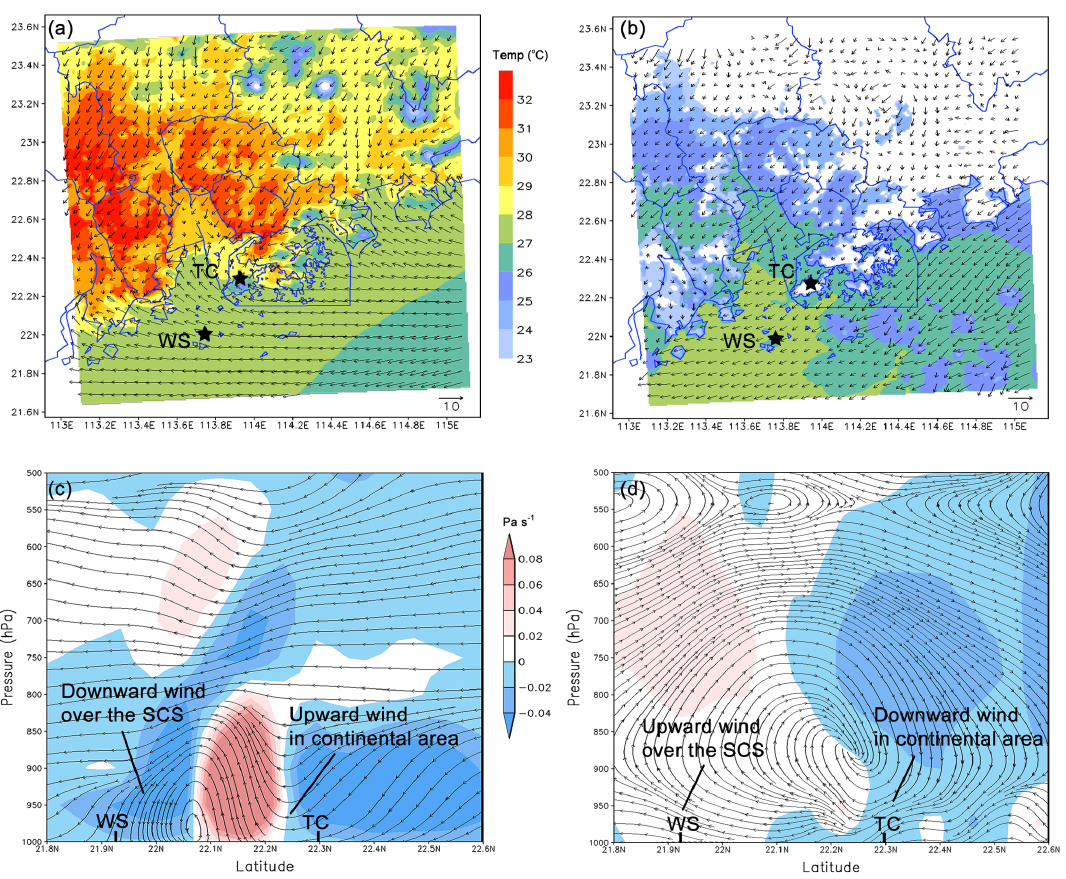
Figure 4. SLB circulation on 3–4 October 2013, showing surface wind pattern (arrows) and temperature (color) at 17:00 on 3 October (a) and at 04:00 on 4 October (b) . Vertical cross section (taken over a longitude of 113.85 ◦ E, mean of the longitudes of TC and WS) depicting the v – w wind stream (arrow) and the index of ω · 100 (color) at 17:00 on 3 October (c) and at 04:00 on 4 October (d) . For panels (c) and (d) , the blue color (negative) and light red color (positive) present downward and upward winds, respectively. Panels (a) and (c) represent a sea breeze, and panels (b) and (d) show a land breeze. Note that ω is the vertical velocity in isobaric